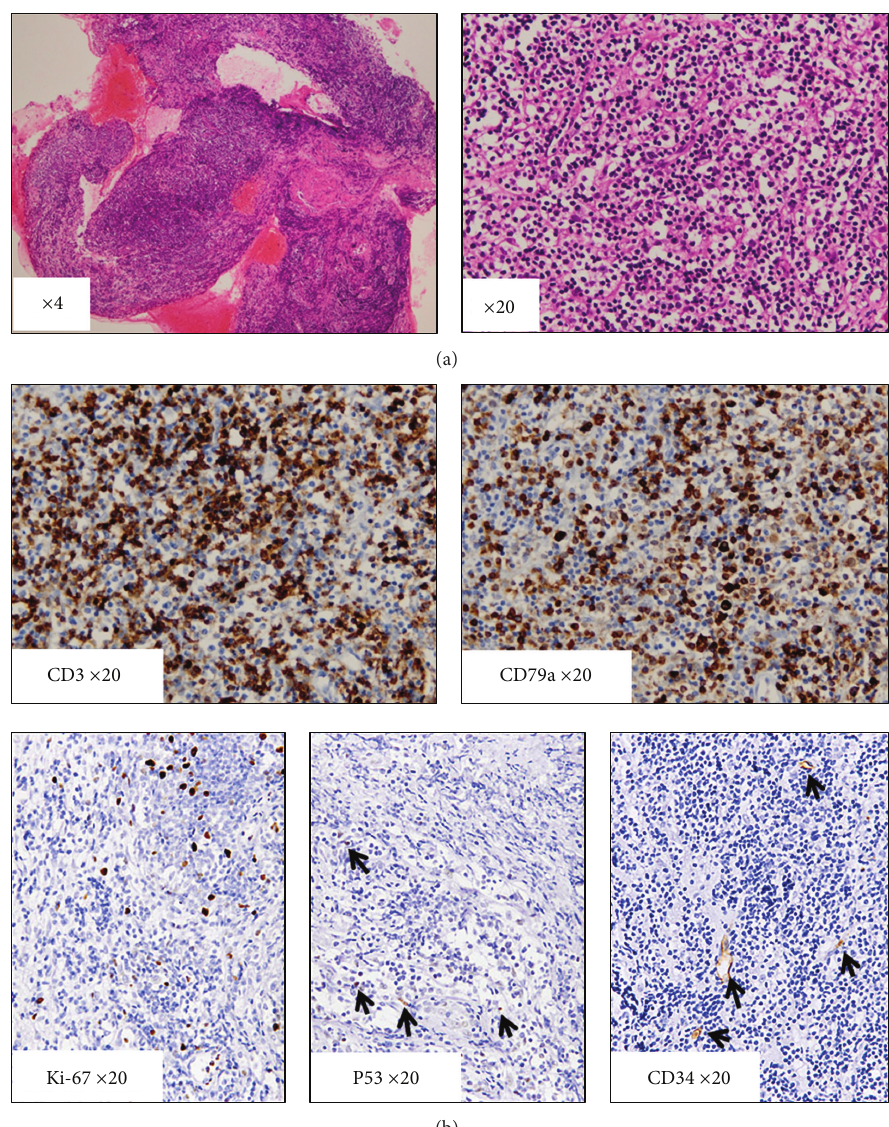
Figure 2: (a) Hematoxylin-eosin (HE) staining. Marked lymphocytic infiltration was found in the lesion. Infiltrating lymphocytes were small in size. (b) Immunohistochemical staining. Infiltrating lymphocytes consisted of CD3-positive T-cells and CD79a-positive B-cells. Infiltrating lymphocytes revealed low Ki-67 and P53 positivity. CD34 expression was limited in the vascular endothelial